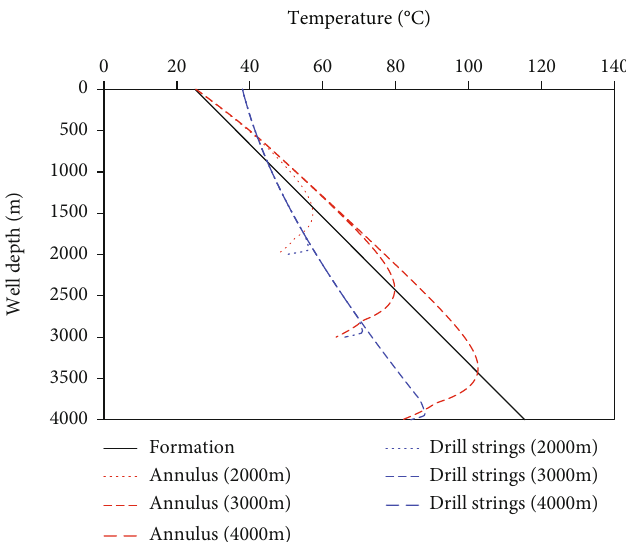
Figure 5: Temperature pro fi le of inside drillstrings, annulus, and formation at di ff erent depths drilled.